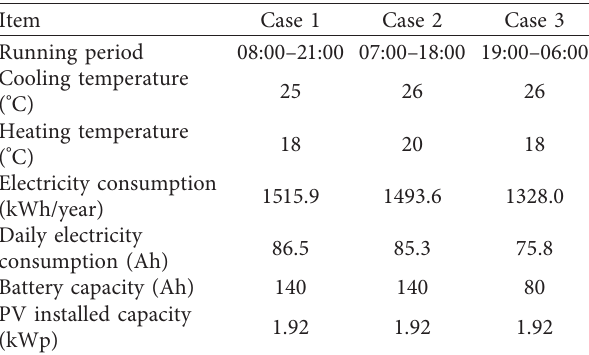
Figure 2: Theoretical yearly electricity consumption of three cases. Table 8: Annual electricity consumption and technical parameters of three cases.